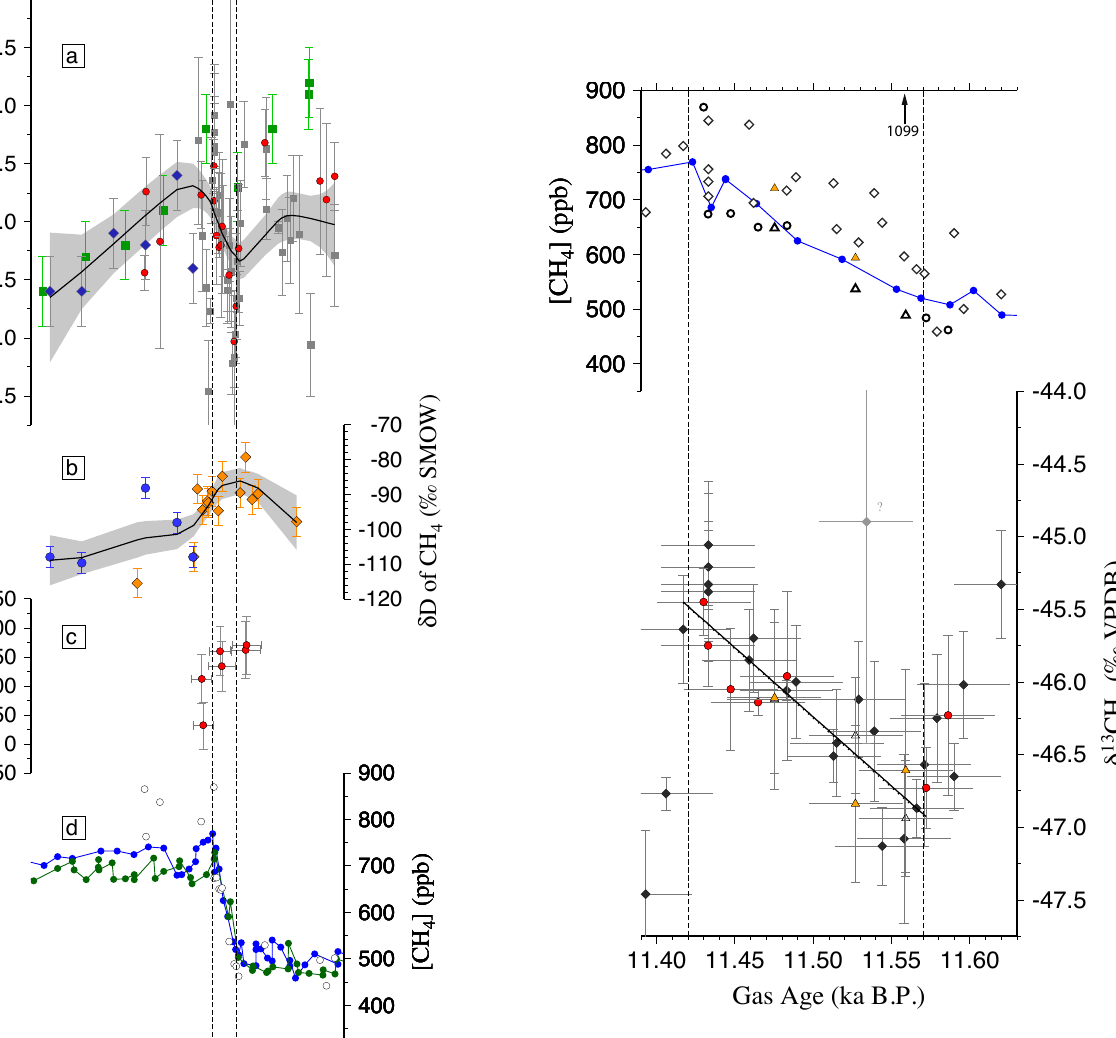
Fig. 3. The δ 13 CH 4 record for the YD-PB including the three sam- ples removed using the data filter. The bottom panel shows δ 13 CH 4 values from this study (red circles and triangles) and Schaefer et al. (2006) corrected for gravitational, diffusional and thermal frac- tionation. The data points, both with those 3 anomalous samples removed [open triangles], and included [yellow triangles] are plot- ted. The weighted linear regression for the entire dataset [dashed line] plots almost on top of the regression for the filtered dataset [solid line]. This demonstrates that the data filter has effectively no effect on the calculated change in the δ 13 CH 4 value across the YD-PB. The top panel is the [CH 4 ] records from GISP2 [blue line] (Brook et al., 2000), Schaefer et al. (2006) [open diamonds], and this study. For our data, open circles indicate data points not influ- enced by the data filter, open triangles are data points that exclude anomalous samples, and yellow triangles include all samples. One value that plots off the scale of the y-axis is indicated by an arrow. The vertical dashed lines show the limits of the